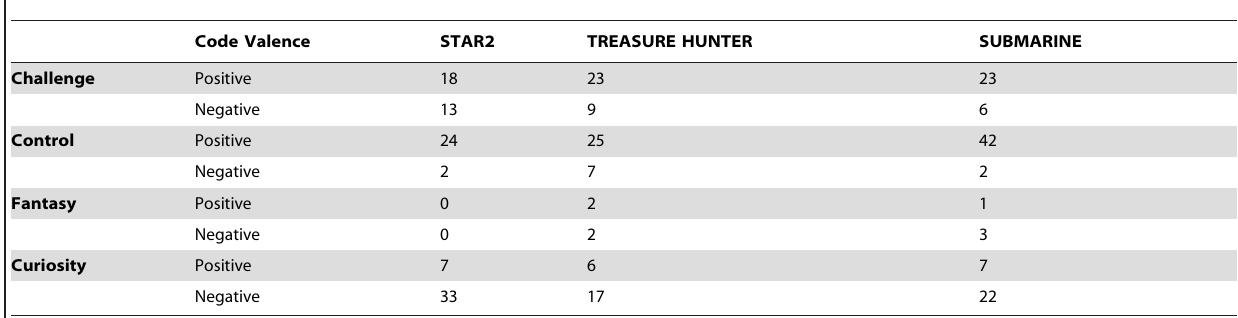
Table 2. Number of codes per